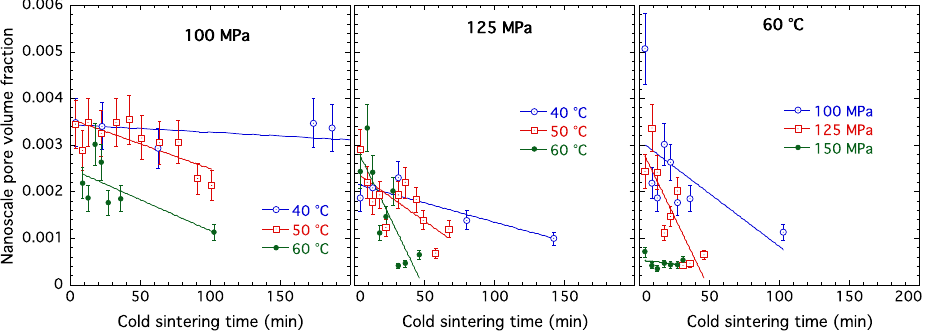
Figure 6. Nanoscale pore volume fraction versus cold sintering time for 40 °C, 50 °C, 60 °C with p = p = 100 MPa and 125 MPa, and for p = 100 MPa, 125 MPa, 150 MPa at 60 ◦ C. Straight-line fits are 100 MPa and 125 MPa, and for p = 100 MPa, 125 MPa, 150 MPa at 60 °C. Straight-line fits are guides guides to the to the eye.